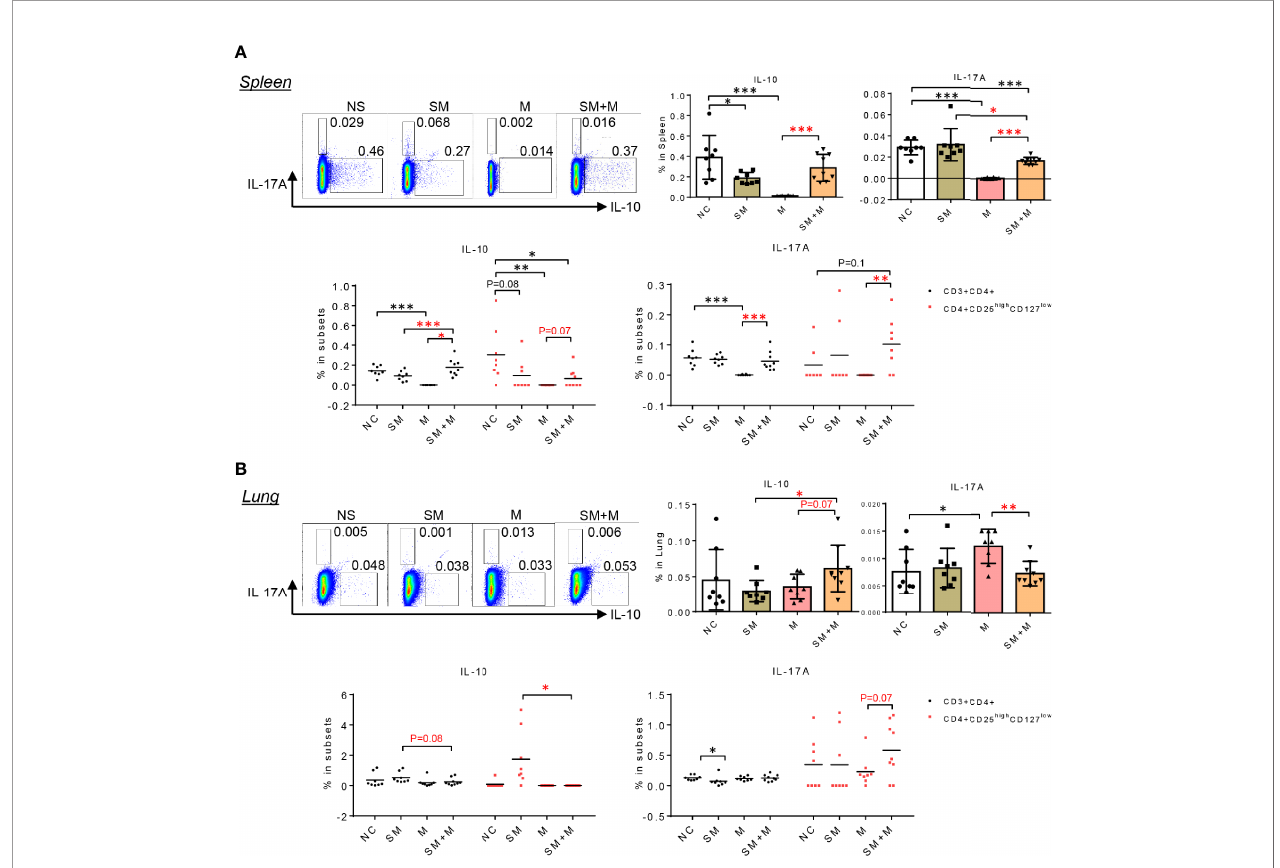
FIGURE 4 | SM + M stimulated IL-17A production in CD4+CD25 high CD127 low Treg cells from spleen and lung. (A) Representative fl ow cytometry gating and quantitative bar graph show the IL-17A and IL-10 production in splenocytes upon treatments. Dot plot indicate the frequency of IL-10 and IL-17A producing cells in CD3+CD4+ T cells and Treg cells. (B) Representative fl ow cytometry gating and quantitative bar graph show the IL-17A and IL-10 production in lung cells upon treatments. Dot plot indicate the frequency of IL-10 and IL-17A producing cells in CD3+CD4+ T cells and Treg cells. (n = 8) (T-test, *p < 0.05, **p < 0.01,***p < 0.001, * in black represents the difference between SM, M or SM+M and NS control, * in red represents the difference between SM+M and SM or